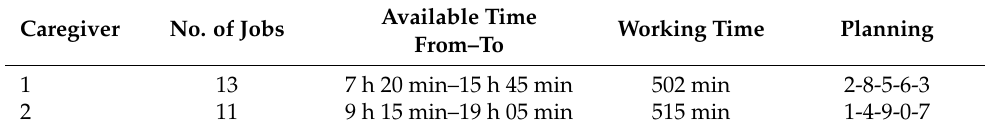
Table 7. Results of instance HHC p 10_ c